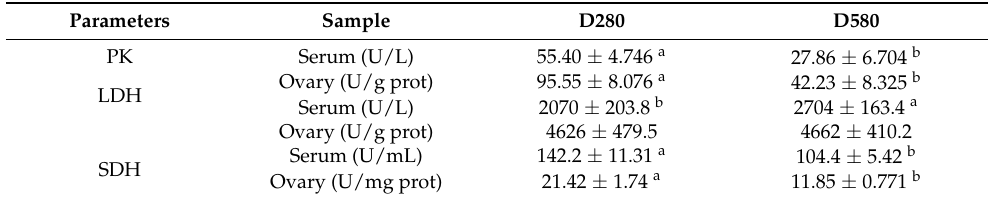
Table 2. Comparison of PK, LDH, and SDH levels in serum and ovaries from D280 and D580 hens. Parameters